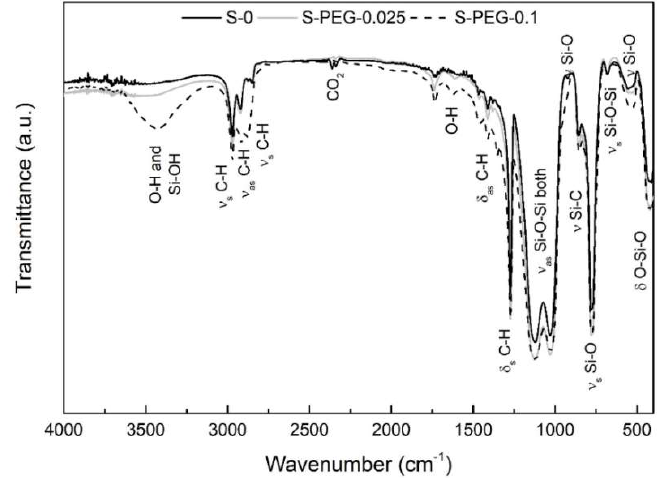
Figure 3. FTIR spectra obtained for aerogel-like samples with and without PEG additive. ν— stretching vibration; ν s —symmetric stretching vibration; ν as —asymmetric stretching vibration; δ— deformation vibration; δ s —symmetric deformation vibration (bending); δ as —asymmetric deformation vibration (bending).